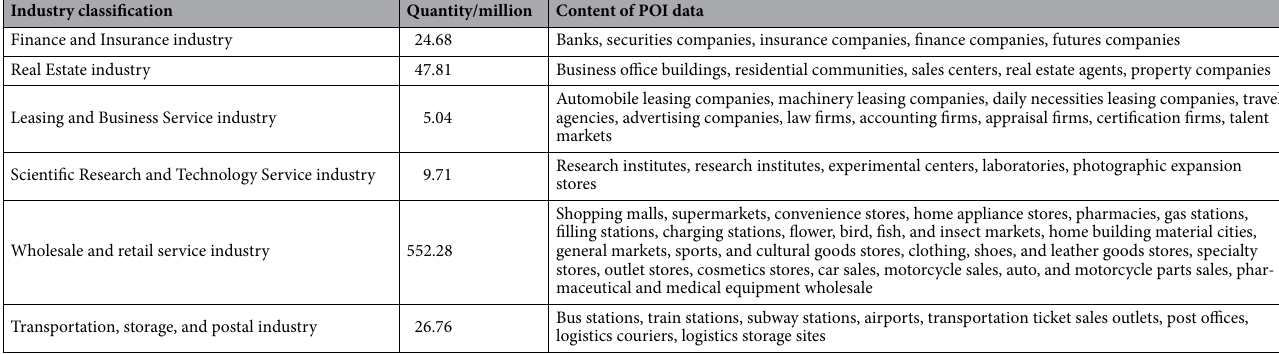
Table 1. Classification of producer services based on POI